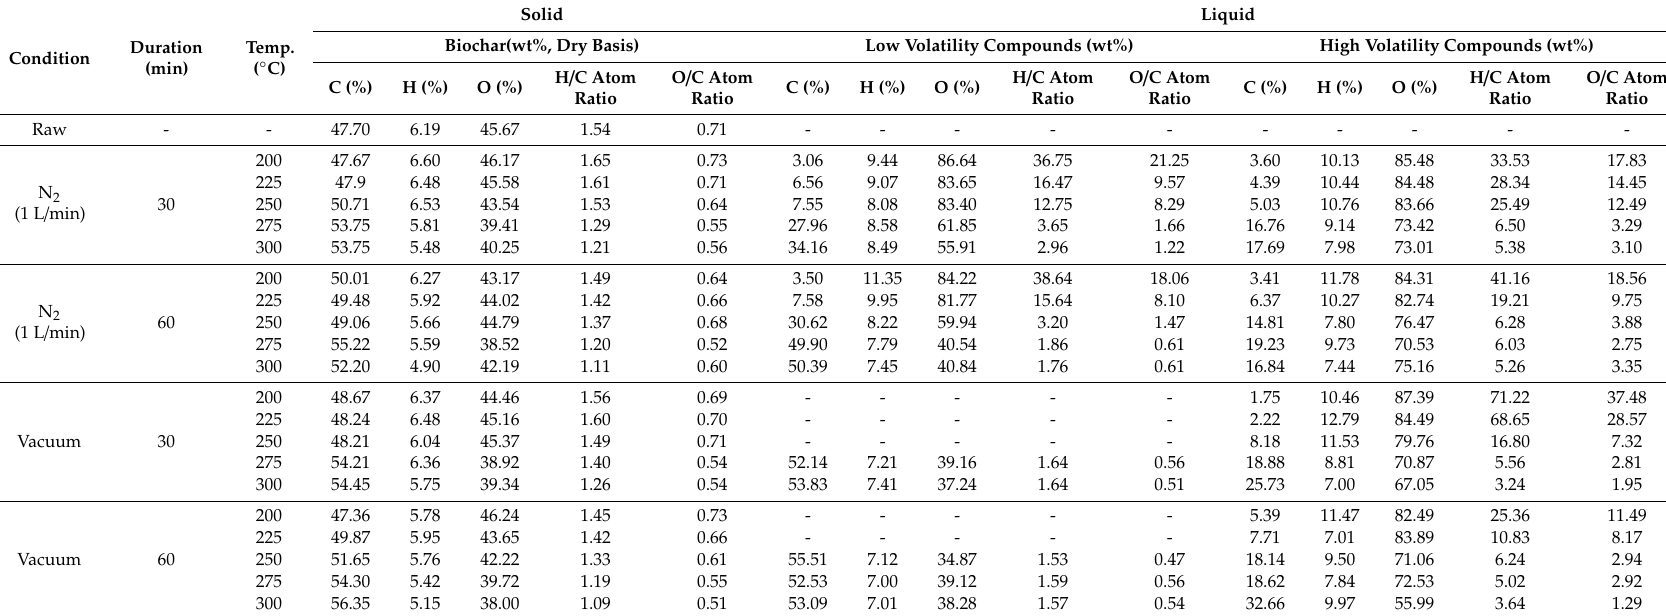
Table 4. Elemental analysis of raw and torrefied samples (dry-ash-free) in vacuum and nitrogen